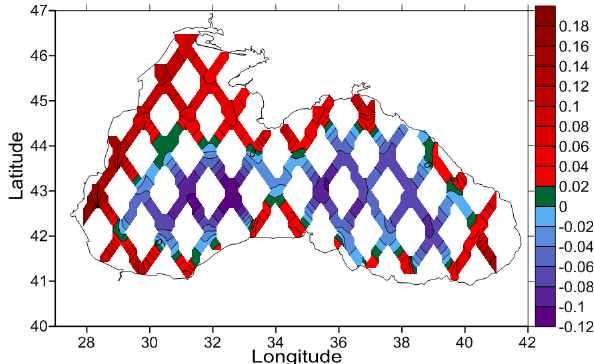
Fig. 5. Along-track mean dynamic topography computed from SLA and drifting buoy